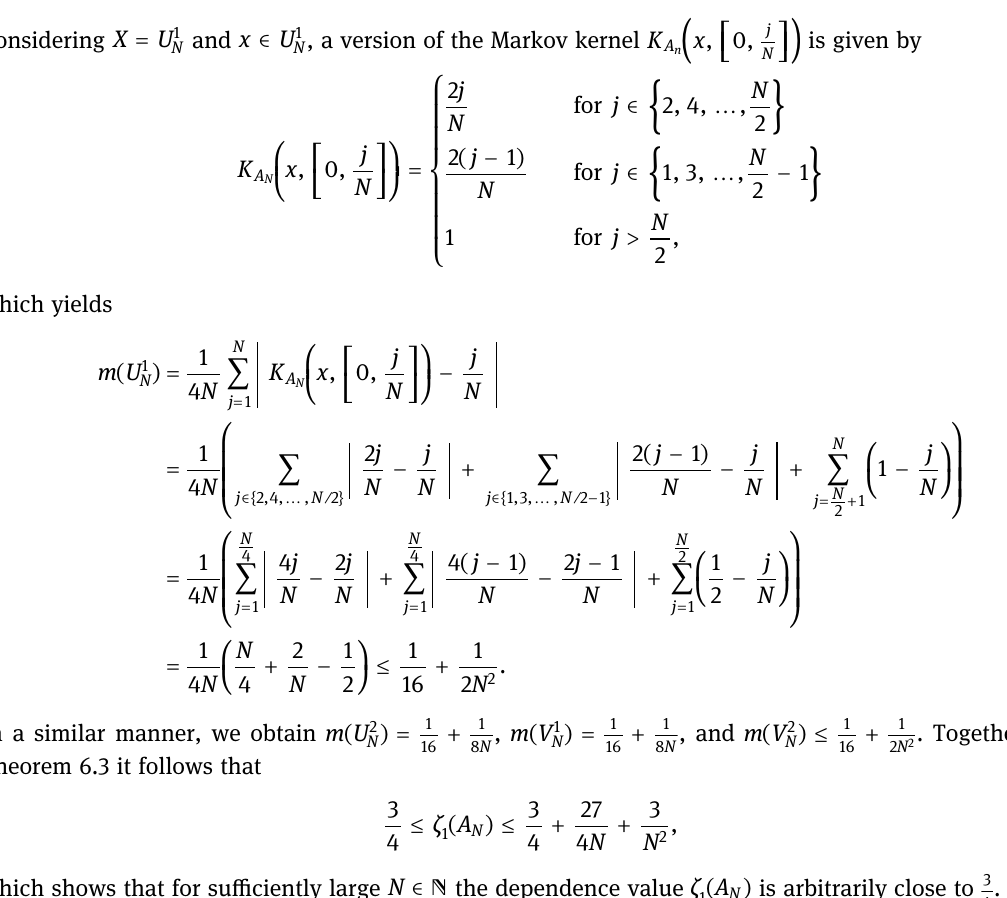
Figure 5: Density of the copula A N ( gray ) as considered in Example 6.4 and support of the mutually completely dependent copula B N ( magenta ) according to Remark 6.5 for N 8 = ( left panel ) and N 32 = ( right panel )